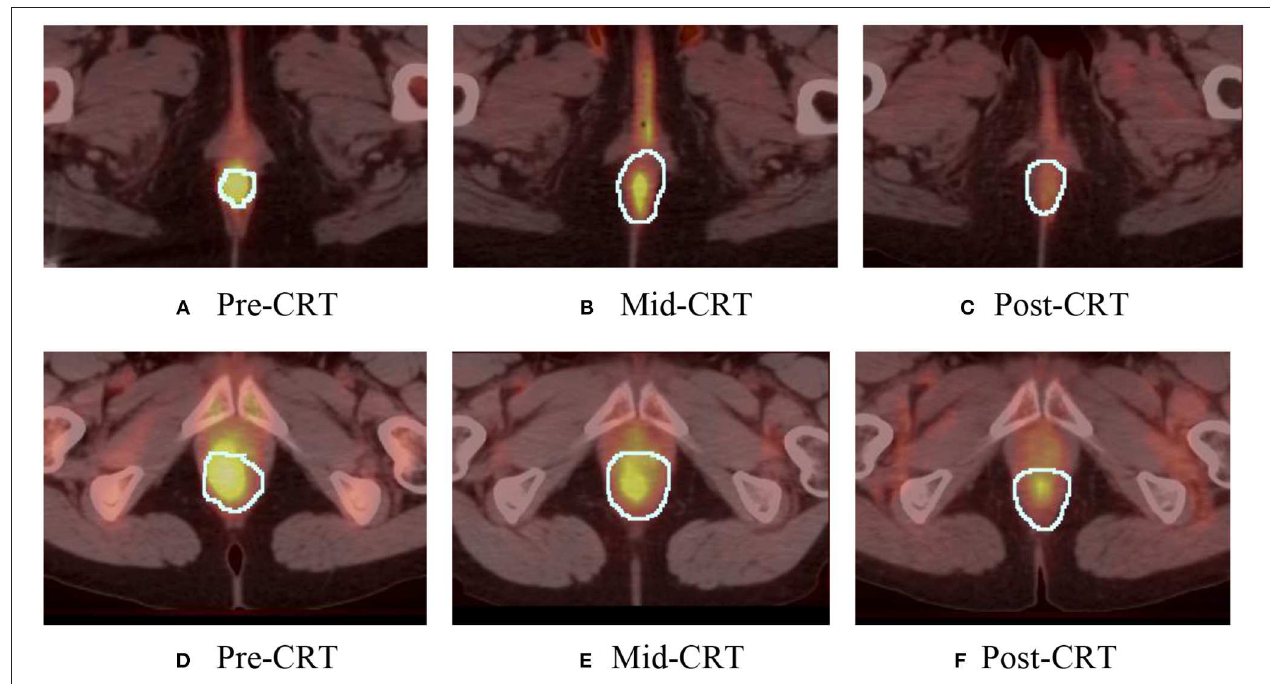
FIGURE 1 | Manually delineated tumor contour (white) in Pre-CRT, Mid-CRT, and Post-CRT scans of a non-recurrent patient (A–C) and a recurrent patient (D–F) Post-CRT. Roundness showed different changing patterns (in Diff3 = Post-CRT – Pre-CRT) between recurrent and non-recurrent groups.